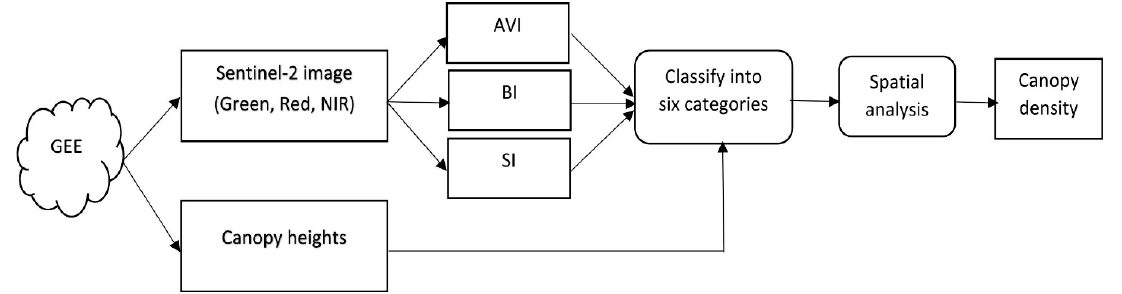
Figure 5. Canopy density model .